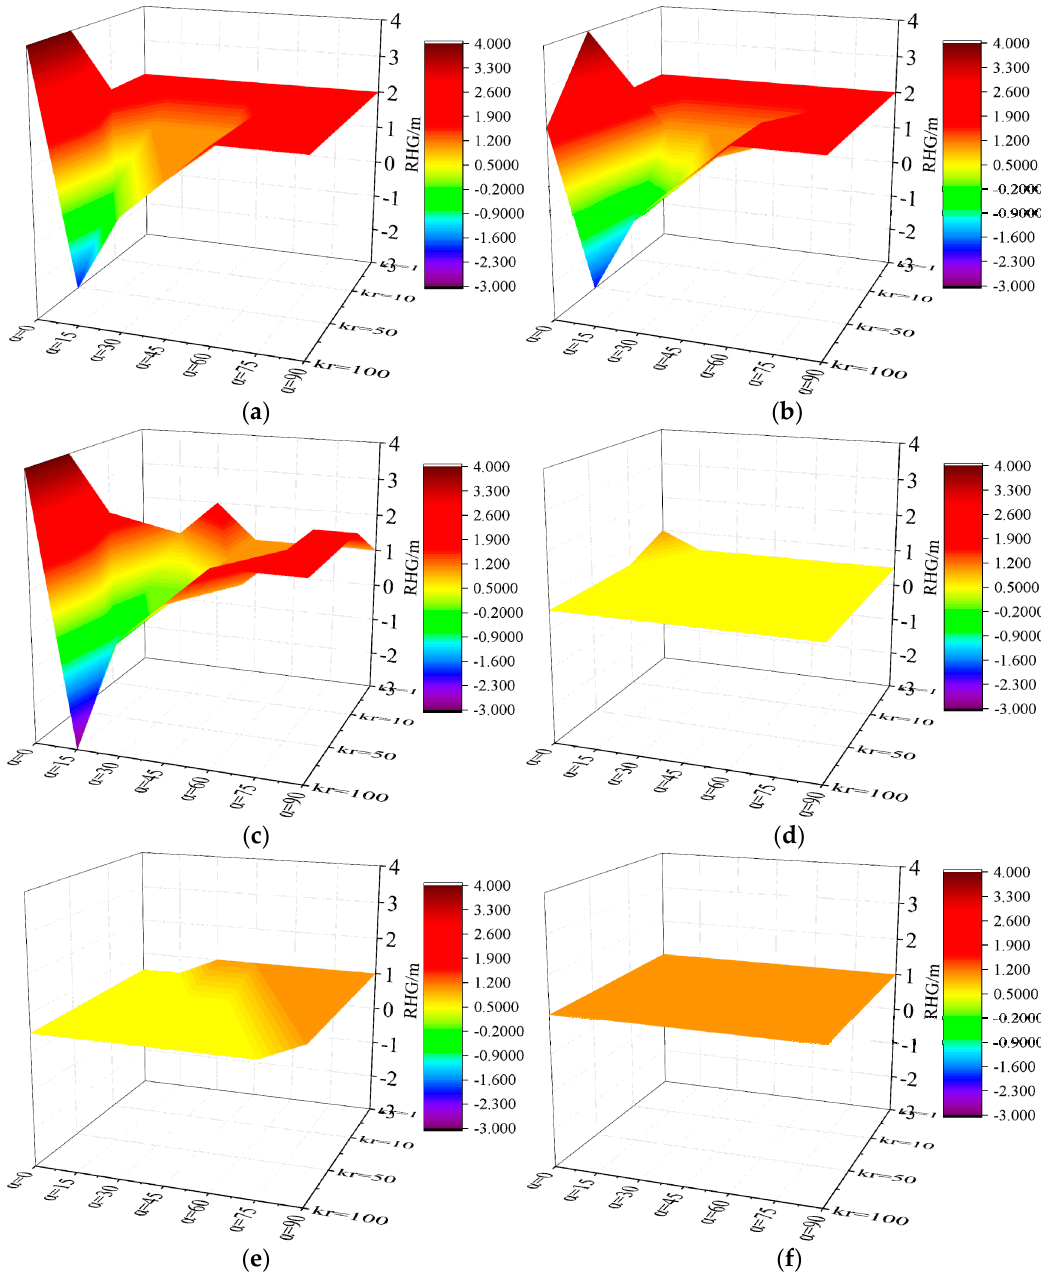
Figure 11. Variation of RID and RHG for clayey and sandy soil. ( a ) Top of the slope for sandy soil. ( b ) Middle of the slope for sandy soil. ( c ) Toe of the slope for sandy soil. ( d ) Top of the slope for clayey soil. ( e ) Middle of the slope for clayey soil. ( f ) Toe of the slope for clayey soil.